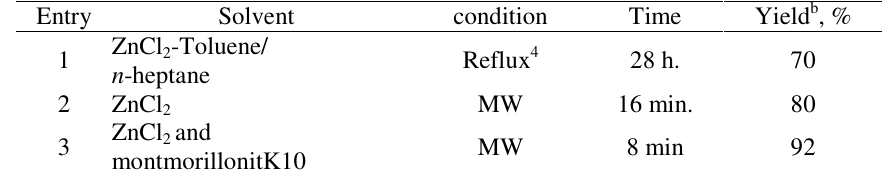
Table 2. Synthesis of 7,8-dihydro-7,7-dimethyl-4-phenyl-2- p -tolyl-4H-chromen-5(6H)-one (3a) catalyzed by ZnCl under various 2